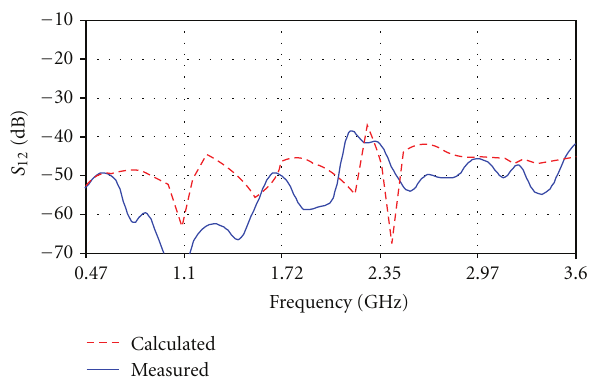
Figure 12: The third dual antenna configuration on a handset.